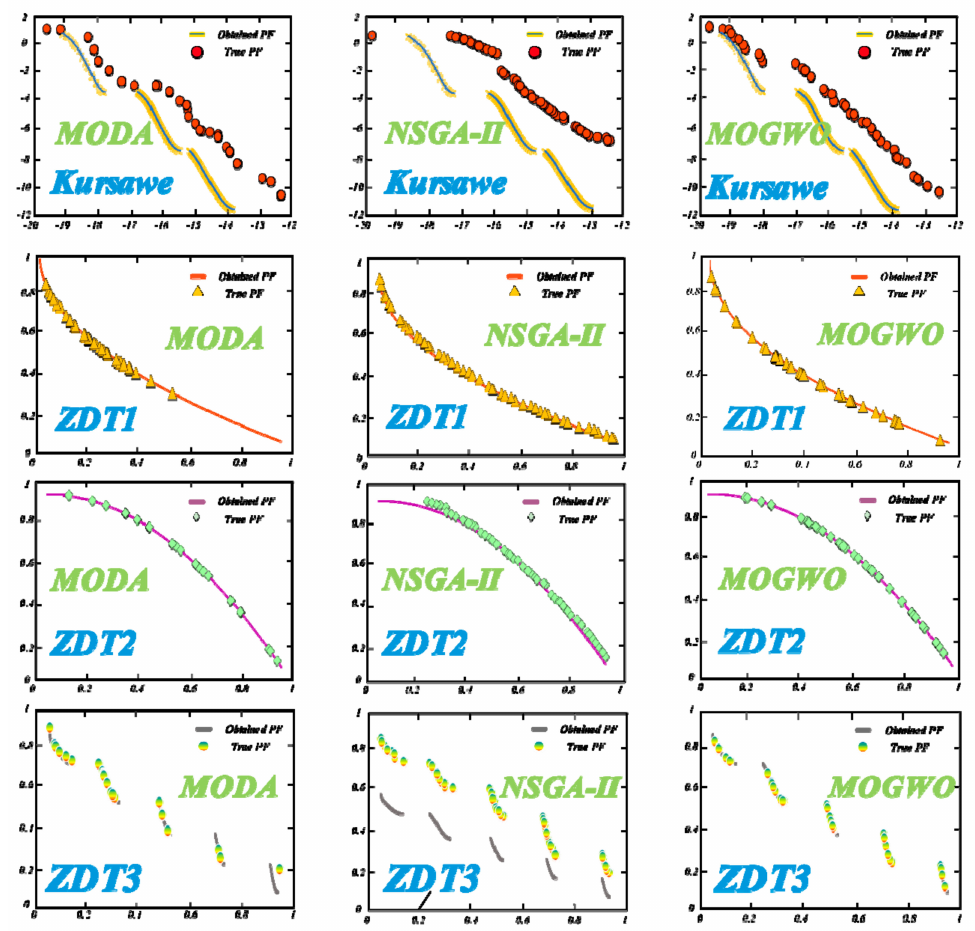
Figure 7. Obtained Pareto optimal solutions by NSGA-II, MODA, and MOGWO for the test functions: Kursawe, ZDT1, ZDT2, and